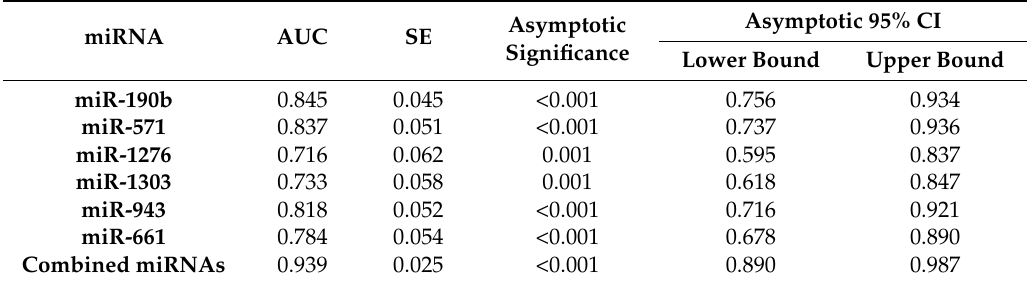
CI, confidence interval; SE, standard error, AUC, area under the curve; ROC, receiver operating